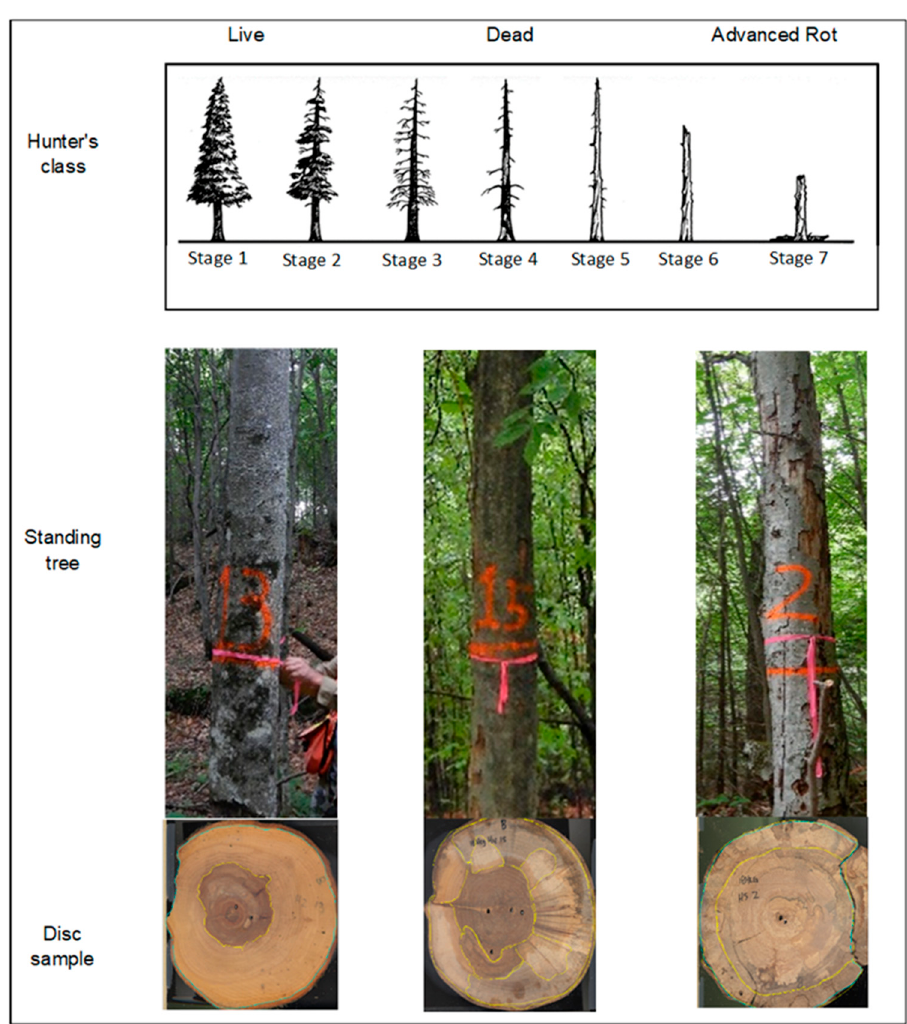
Figure 2. Example of a standing tree and sampled disc for each decay level.